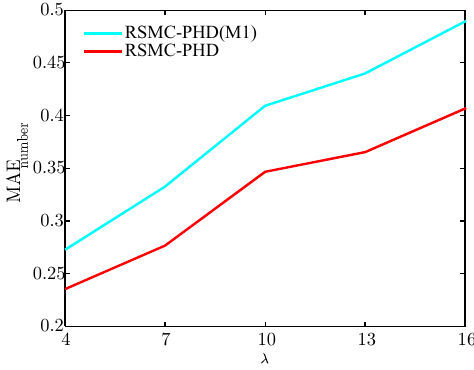
Figure 7. The MAE estimate of target number.